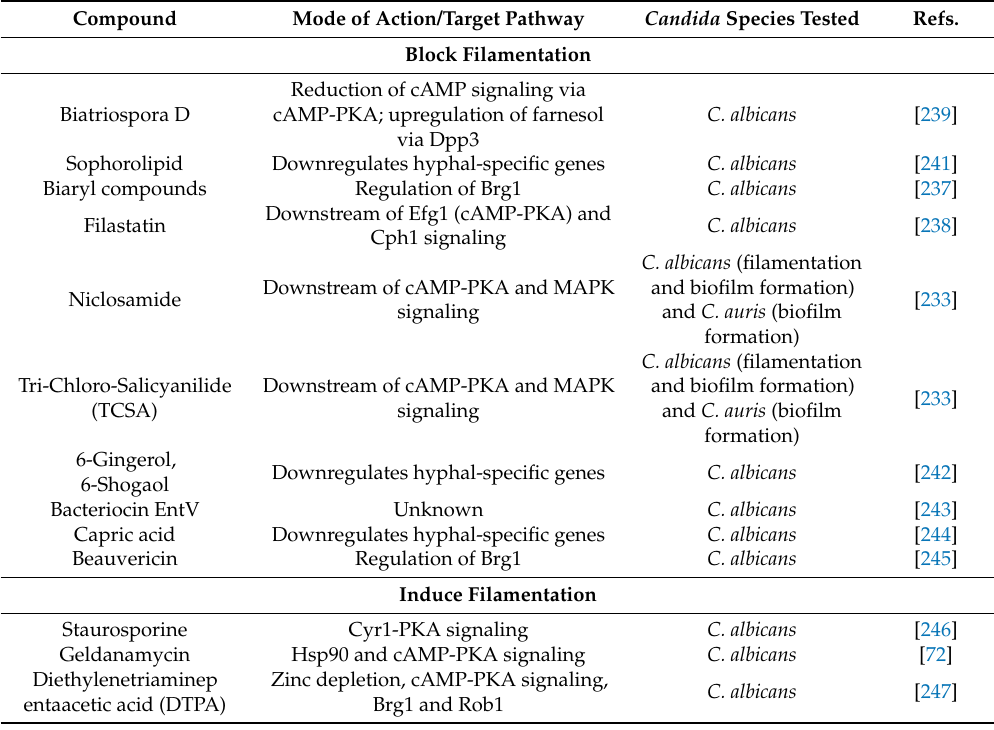
Table 2. Compounds that alter Candida